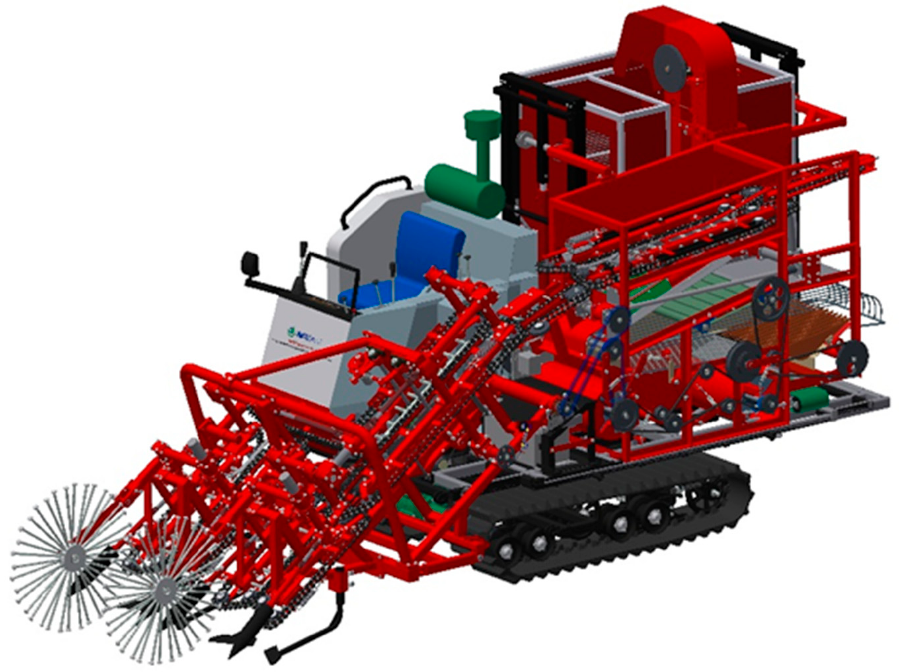
Figure 1. Three-dimensional diagram of a 4HLB-4 half-feed four-row peanut combine harvester.